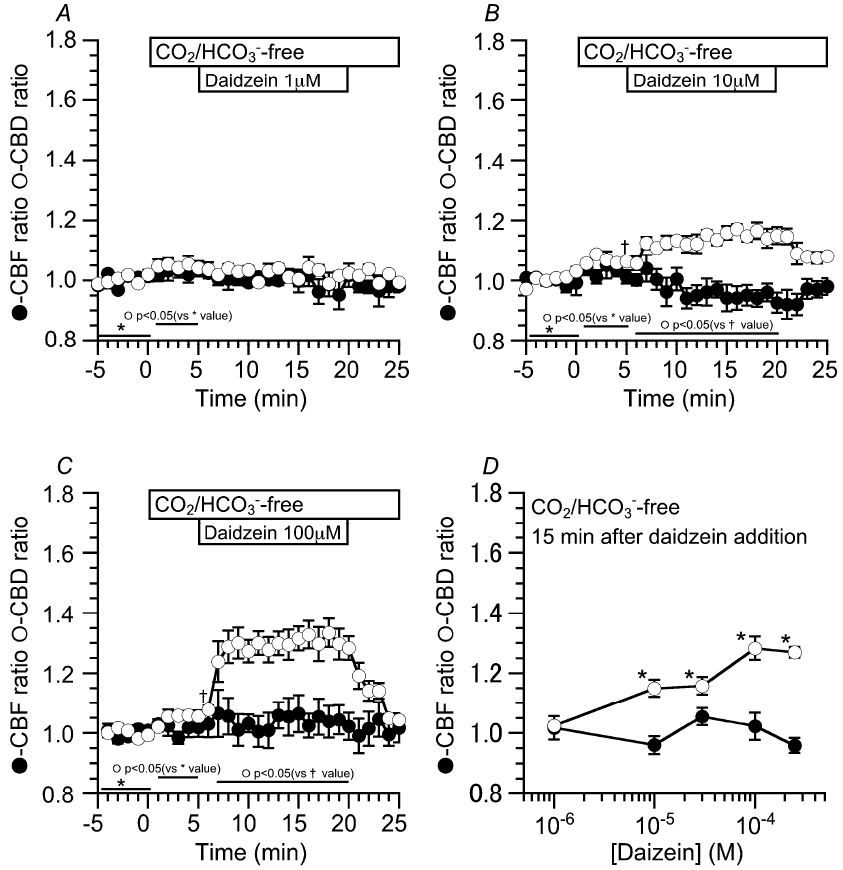
Figure 2. Concentration effects of daidzein on CBD and CBF in cHNECs at 37 ◦ C. Prior to daidzein stimulation, cHNECs were perfused with the CO 2 /HCO 3 − -containing control solution, and then with the CO 2 /HCO 3 − -free control solution. The switch to the CO 2 /HCO 3 − -free control solution induced a small increase in CBD, but not CBF. ( A ) One µ M of daidzein. Stimulation with one µ M of daidzein did not change CBD or CBF. ( B ) 10 µ M of daidzein. Stimulation with 10 µ M of daidzein slightly increased CBD, but not CBF. ( C ) 100 µ M of daidzein. Stimulation with 100 µ M of daidzein increased CBD, but not CBF. ( D ) The concentration response study of daidzein. The ratio of CBD to CBF 15 min from the start of daidzein stimulation was plotted against the daidzein concentration. Daidzein increased